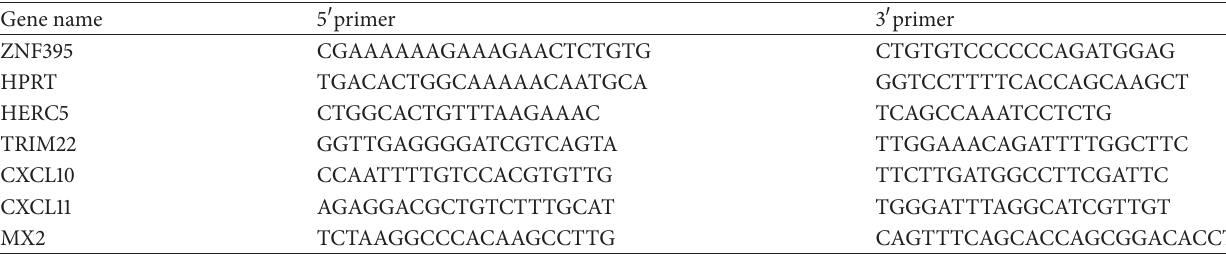
Table 1: Primer for qRT-PCR used in this